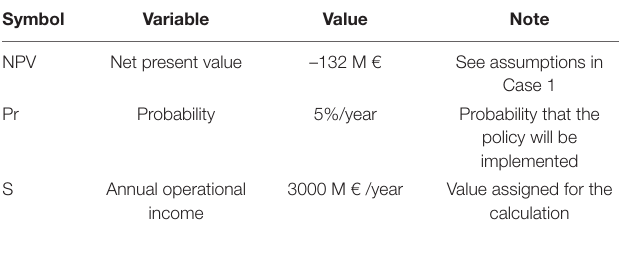
TABLE 4 | Additional parameters for option valuation in step